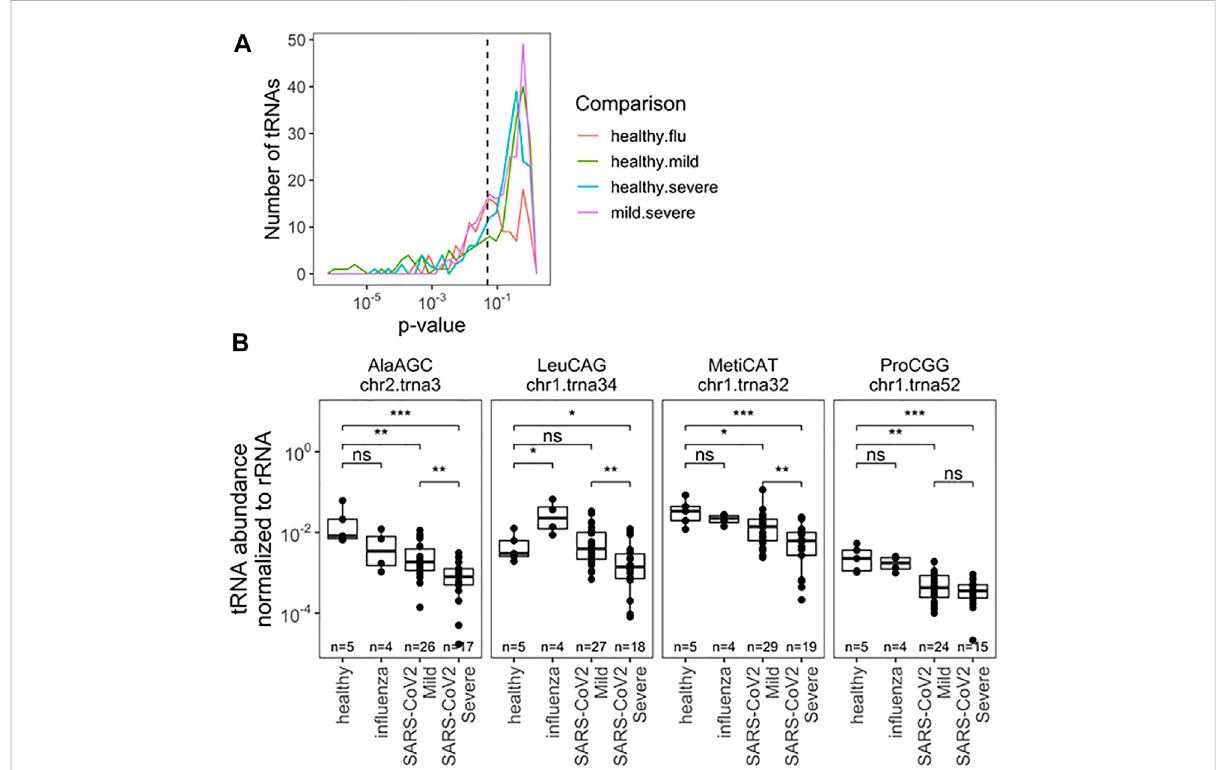
FIGURE 3 Relative abundance of speci fi c tRNA isodecoders to 5.8S rRNA in the same RNA samples allowes for separation by infection status (uninfected, in fl uenzaandSARS-CoV-2infectedindividuals). (A) Uncorreced p -Valuesforpairwisetwo-sidedt-testsindicateseveralnotabledifferencesinrRNA- normalized abundance among speci fi c. tRNA isodecoders. Analysis inciudes all sense-mapped reads for each isodecoders. Precisee values are indicated in Supplementary Table S3. (B) rRNA-normalized abundance for notable abundance tRNAs are highlighted tRNA Ala (ACG),c2t3tRNA Mct (CAT), and tRNA Leu (CGG)c1t34. In addition to distinguisting among SARS-Cov-2 patients, normalized abundance of tRNA Pro (CGG)c1t52. amoung others, can provide diagnostic insight which compared to healthy patients.* < 0.05; ** < 10 − 2 ;*** < 10 − 3 ;**** < 10 − 4 . Two- side t -tests with the number of samples passing a 10 read fl iter indicated in each